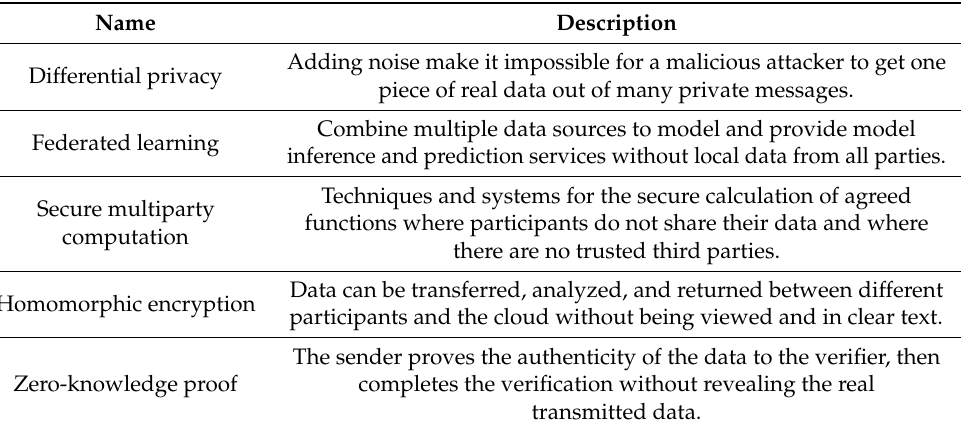
Table 5. Privacy computing for information